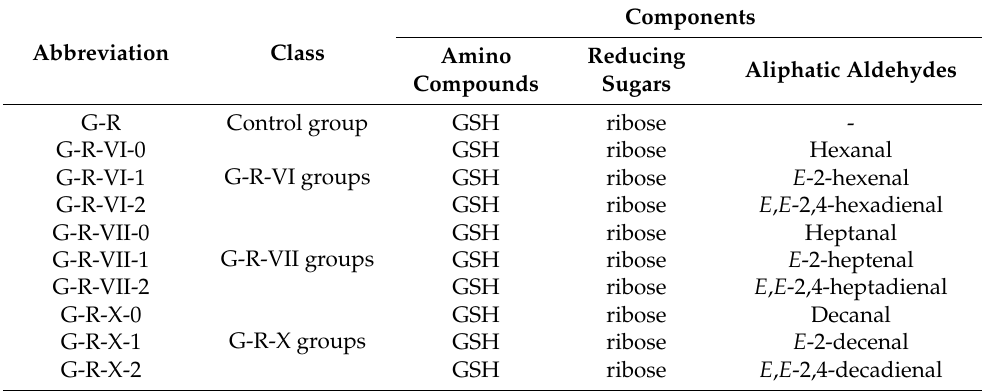
Table 1. Composition and notation of the reaction systems in each experimental